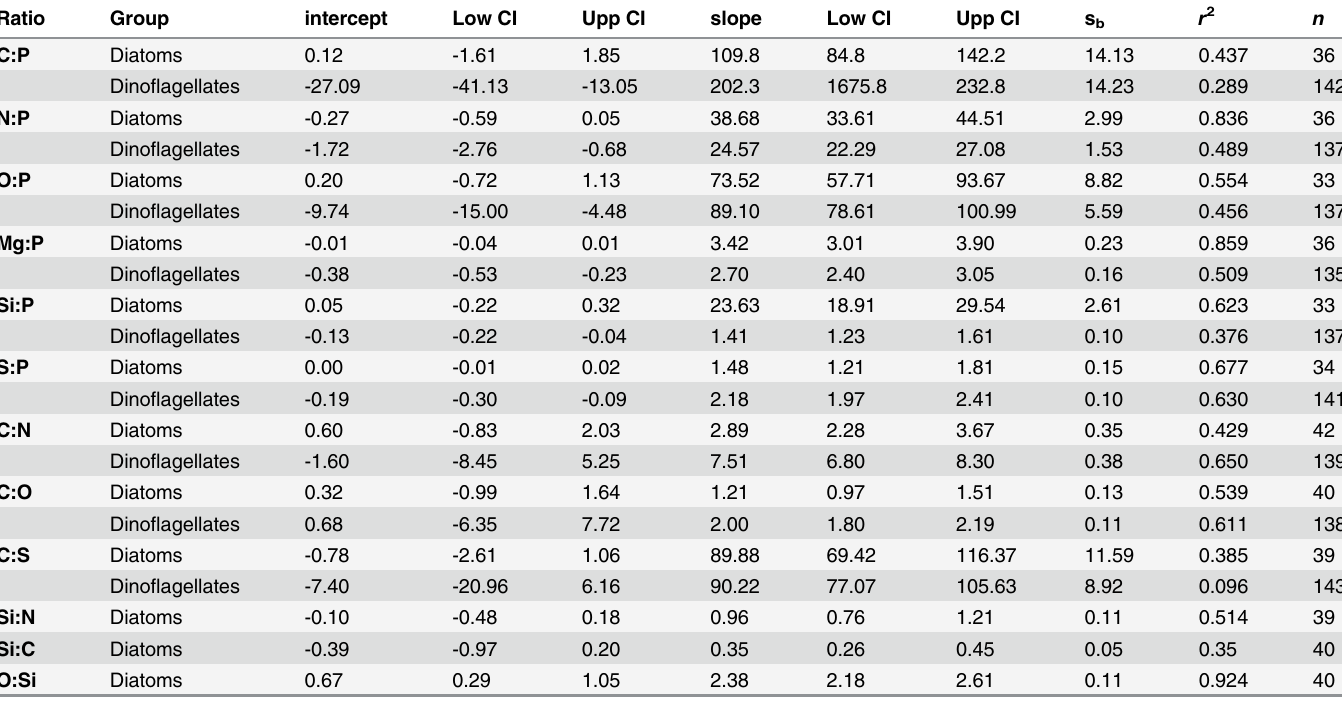
Table 4. Results of the least square regression of different molar ratios (element vs . element) of single phytoplankton cells.